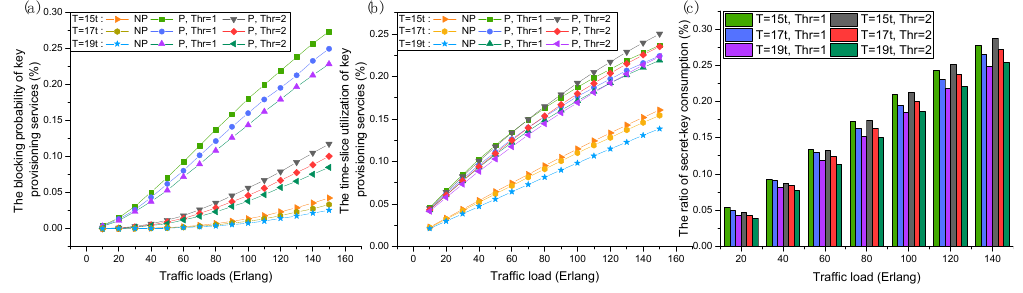
Figure 10. ( a ) The blocking probability, ( b ) the resource utilization, ( c ) the ratio of secret-key consumption.